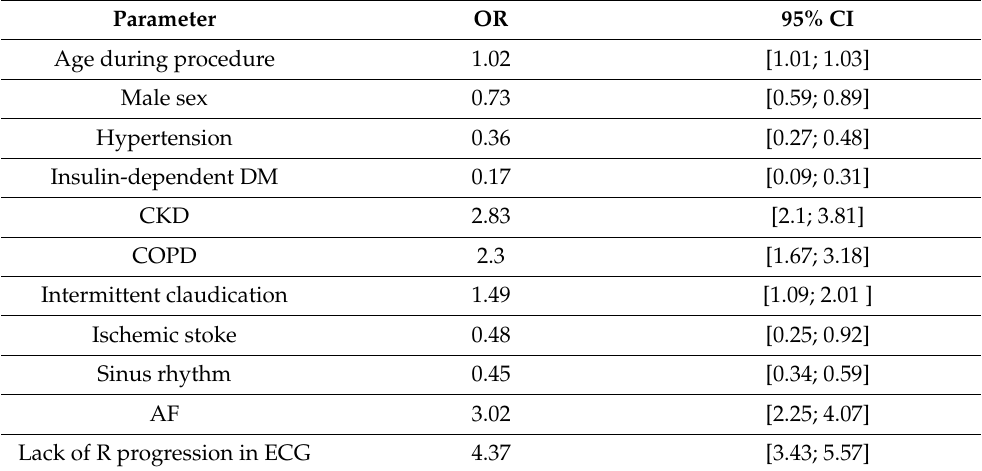
Table 2. Results of one-dimensional logistic regression for CAD vs. CG (where the CAD group was the